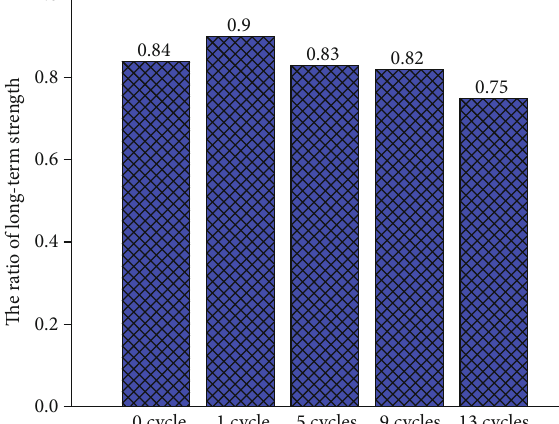
Figure 21: Long-term strength ratio of the tested red sandstone under 2MPa of con fi ning pressure for di ff erent numbers of freeze- thaw